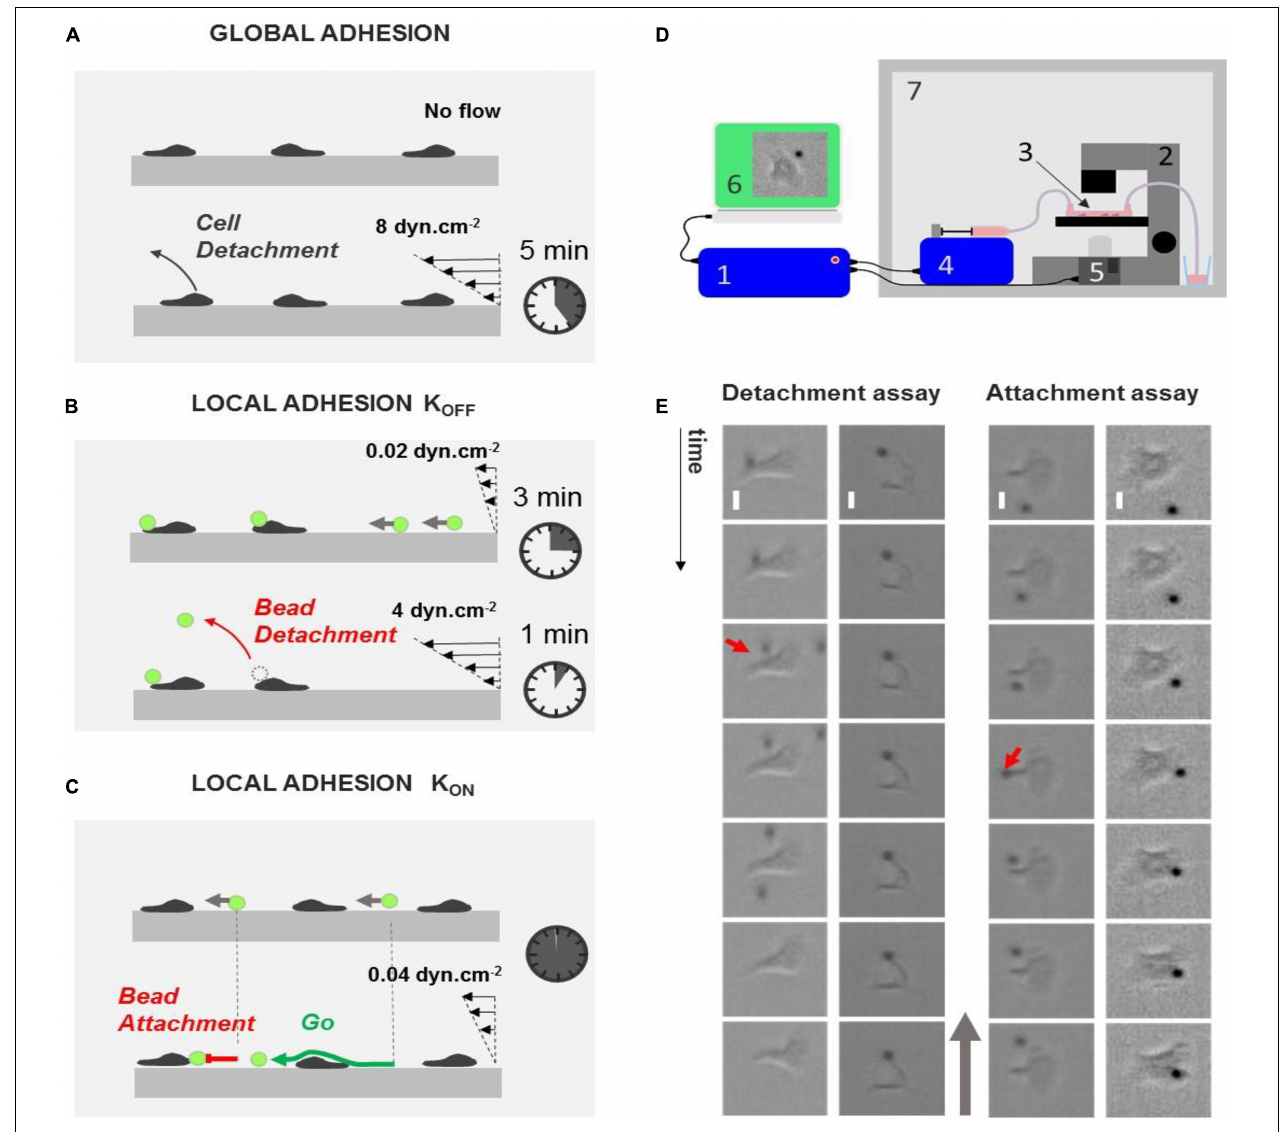
FIGURE 1 | Laminar flow chamber to measure global and local adhesion. (A) Cartoon depicting the principle of flow chamber assay to probe cell adhesion. Cells (gray) are seeded without flow until they adhere and crawl. Their detachment under flow is then monitored versus time. (B,C) Cartoons depicting the principle of our flow chamber assays to probe local adhesion of the surface of cells using beads coated with CAM molecules (green). (B) Detachment experiment. Beads are injected at constant low flow, and they eventually adhered to cells upon random encounter. Flow is then increased, and bead detachments under flow are monitored versus time. (C) Attachment experiment. Beads are injected at a constant low flow, and their attachment frequency with cells is monitored. (D) Schematic of the automatized setup to repeat bead injection, multiple flow sequences, and image acquisitions. Schematics of the experimental setup. 1, controller; 2, optical microscope; 3, flow chamber; 4, controlled syringe pump; 5, controlled camera; 6, acquisition computer; 7, temperature-regulated cabinet. (E) Left—examples of events in detachment experiments with a bead remaining attached to lamellipods (left, from top to bottom: t = 0, 10, 20, 30, 40, 50, and 60 s) and a bead detaching from a cell uropod (right, from left to right: t =0 s, 2500 ms, 5840 ms, 6000 ms, 12 s, and 24 s). Red arrow points to detachment. Scale bar 5 µ m. Right—examples of events in attachment experiment with a bead attaching on lamellipods (left, from top to bottom: t = 0 s, 160 ms, 360 ms, 560 ms, 12 s, 24 s, and 36 s) and a bead passing along a cell uropod without attaching (right, from top to bottom: t = 0, 1, 2, 3, 4, 5, and 6 s). Red arrow points to attachment. Gray arrow indicates flow direction. Scale bar 5 µ m.